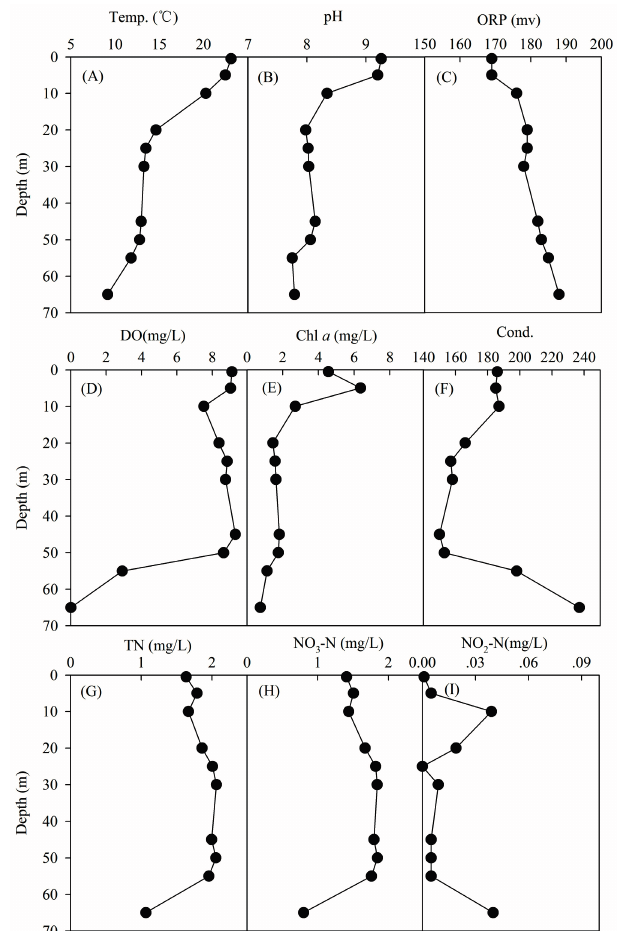
Figure 1. Vertical change of water quality parameters of the JINPEN drinking water reservoir during thermal stratification. Water parameters are including ( A ) temperature (abb. Temp.), ( B ) pH, ( C ) ORP, ( D ) dissolved oxygen, ( E ) chlorophyll a (abb. Chl a), ( F ) conductivity (abb. Cond.), ( G ) total nitrogen, ( H ) nitrate nitrogen, and ( I ) nitrite